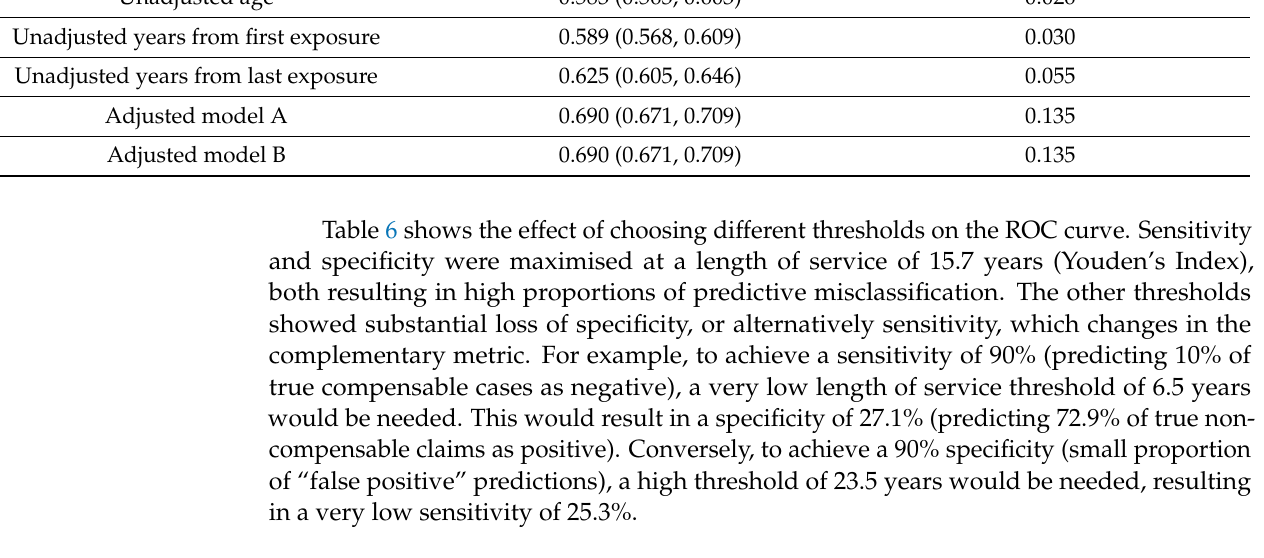
Table 6. Length of service threshold, sensitivity, and specificity based on receiver operating character- istic curve for compensable silicosis (N =